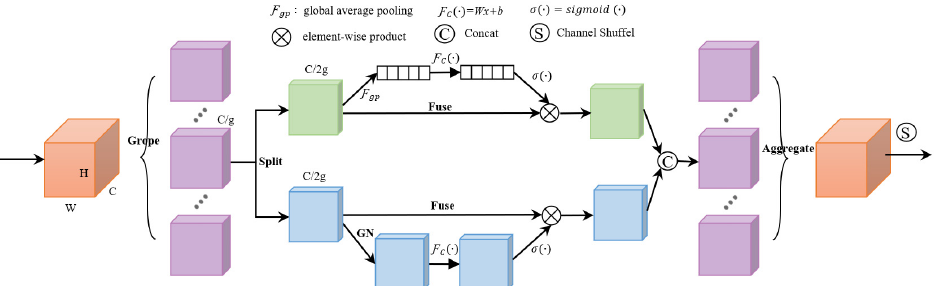
Figure 6. Shuffle Attention network structure. The input features are divided into G groups of sub-features according to the channel dimension, and then each group of sub-features is divided into two branches; channel and spatial attention are performed on the two branches, respectively, and then the two branches are concat to achieve information fusion within the group, and finally channel shuffle is used to realize the information interaction between different sub-features.